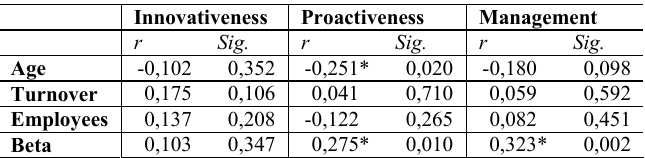
Table 4: Spearman’s rank-order correlation